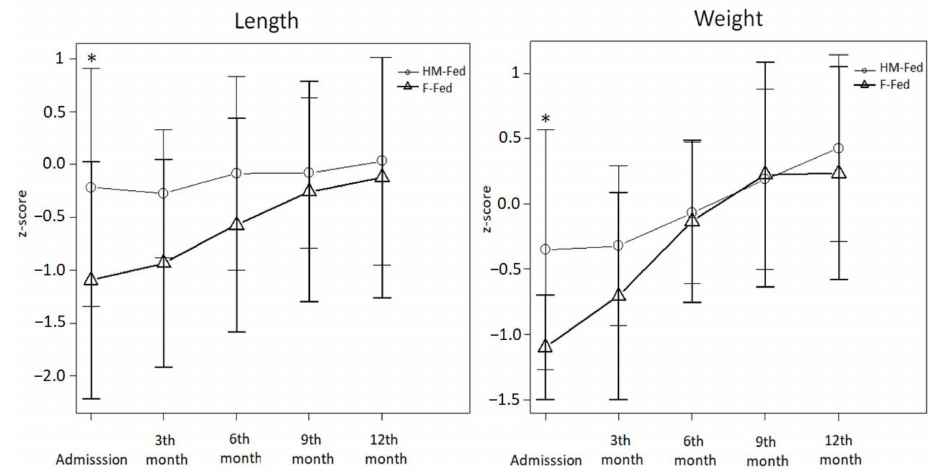
Figure 3. Length and Weight growth curve (WHO) of breastfed (HM-fed) and non-breastfed (F-Fed) PKU infants. Repeated-ANOVA measures were performed to study the variables at each time with data grouped into two categories. For the length variable no statistically significant association can be found between groups and time ( p -value 0.197), for the weight variable statistically significant association can be found between groups and time ( p -value 0.004). We also performed the Mann– Whitney U test (* in figure) each time, finding a significant difference for both length and weight upon admission to our clinic (respectively, p = 0.03 and p =